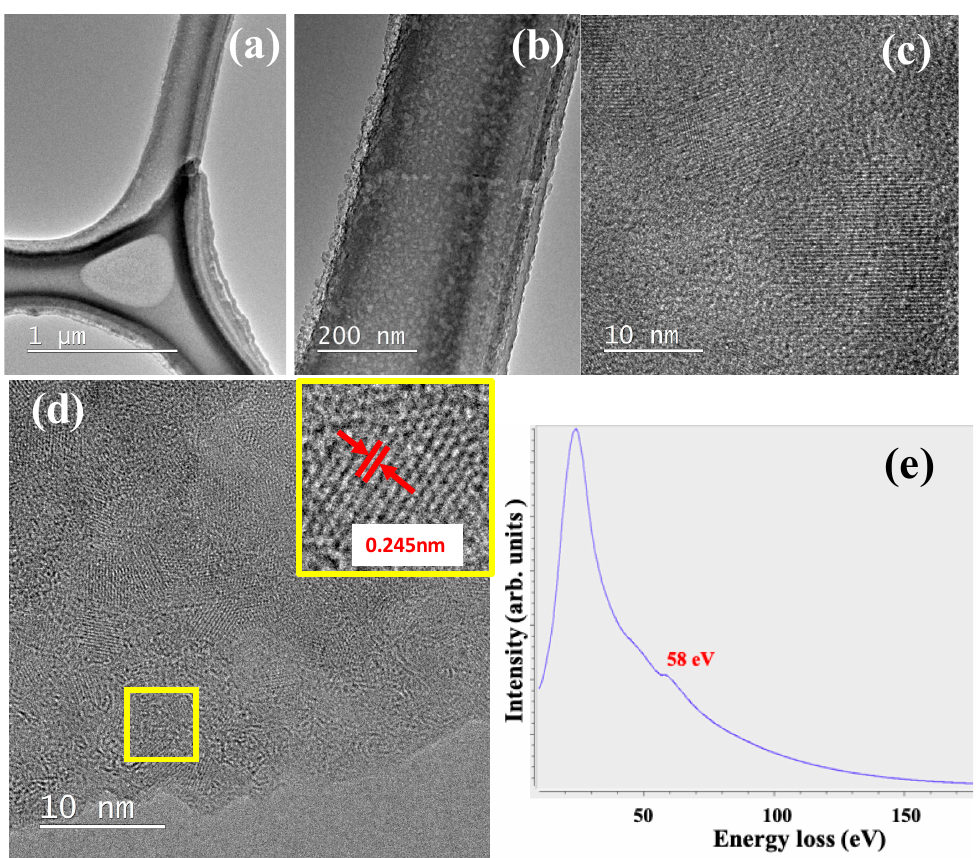
Figure 4. ( a ) Low mag TEM showing Li-C NC film deposited on TEM mesh. ( b ) Typical Li-C NC film showing dark and bright spots indicating different distributions of Li and C. ( c ) High mag TEM image showing Li lattice in C matrix before annealing. ( d ) Li-C NC film after annealing for 10 min at 300 °C. The inset presents the squared area showing the intact Li lattice ( e ) EELS spectra taken on the annealed sample showing the presence of pristine Li.